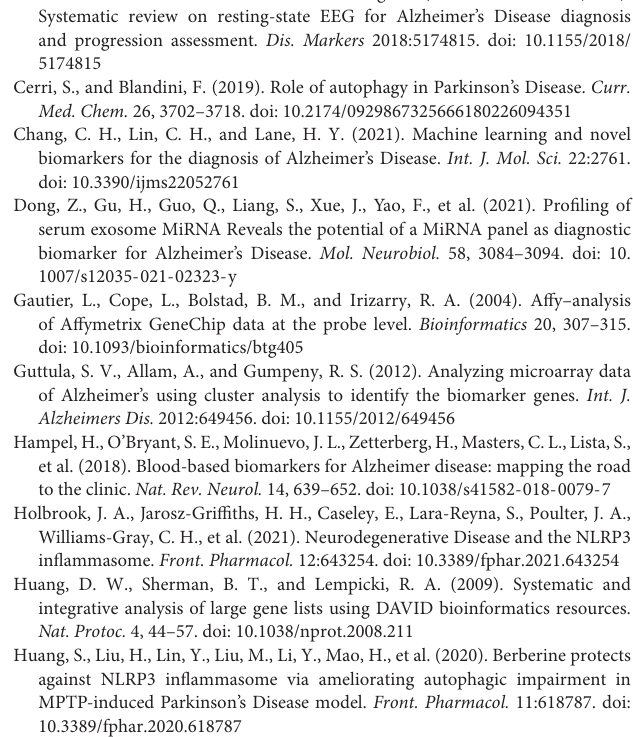
Supplementary Figure 1 | Genetic functional analysis of DE-ATGs. (A) GO and KEGG enrichment analyses of DE-ATGs. (B) DisGeNET database enrichment analysis of diseases concerning DE-ATGs. (C) Tissue characteristics of DE-ATGs as analyzed using the PaGenBase database. Supplementary Figure 2 | Calibration curve analysis. (A) Calibration curve of the PD nomogram prediction. (B) Calibration curve of the stroke nomogram prediction. (C) Calibration curve of acute CNS injury nomogram prediction. PD = Parkinson’s disease; acute CNS injury = acute central nervous system